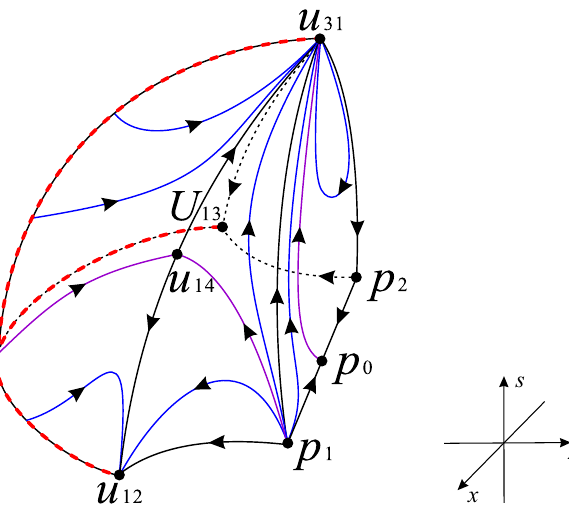
Fig. 8 Phase portrait in the front boundary of the region R 1